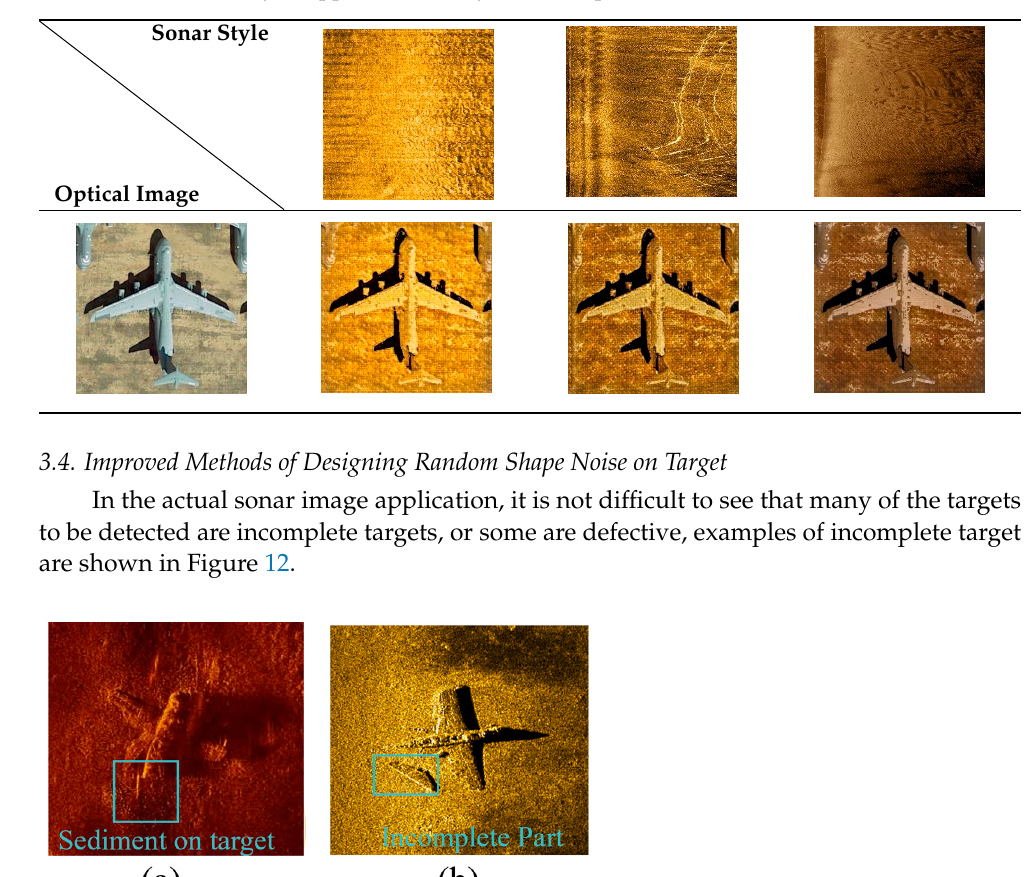
Figure 11. Frequency analysis on enhancement style transfer sample image. ( a ) Gray image on using style transfer directly. ( b ) Fourier transform on sonar image. ( c ) Gaussian filter frequency in frequency image. ( d ) Gaussian filtered image. Table 2. Three sonar styles applied on our style transfer process.